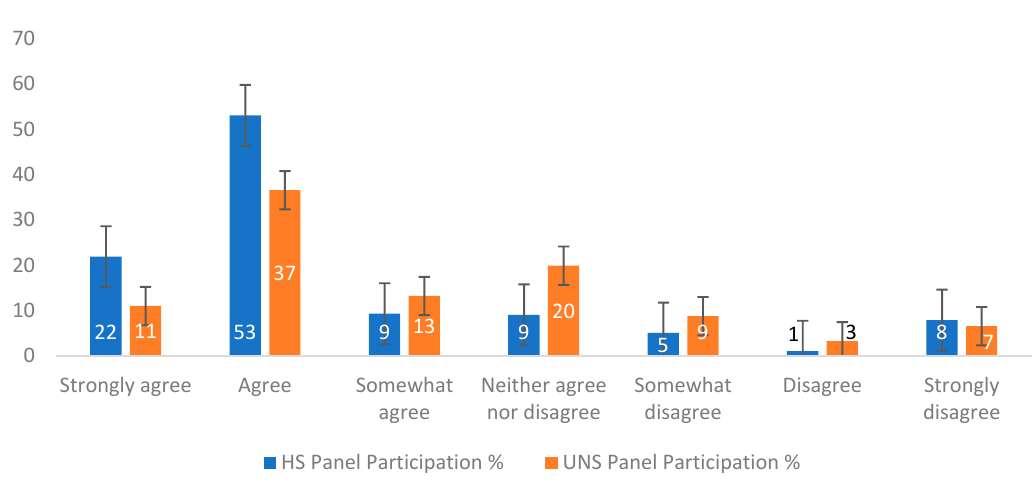
Figure 11. Panel participated equally in the interview.